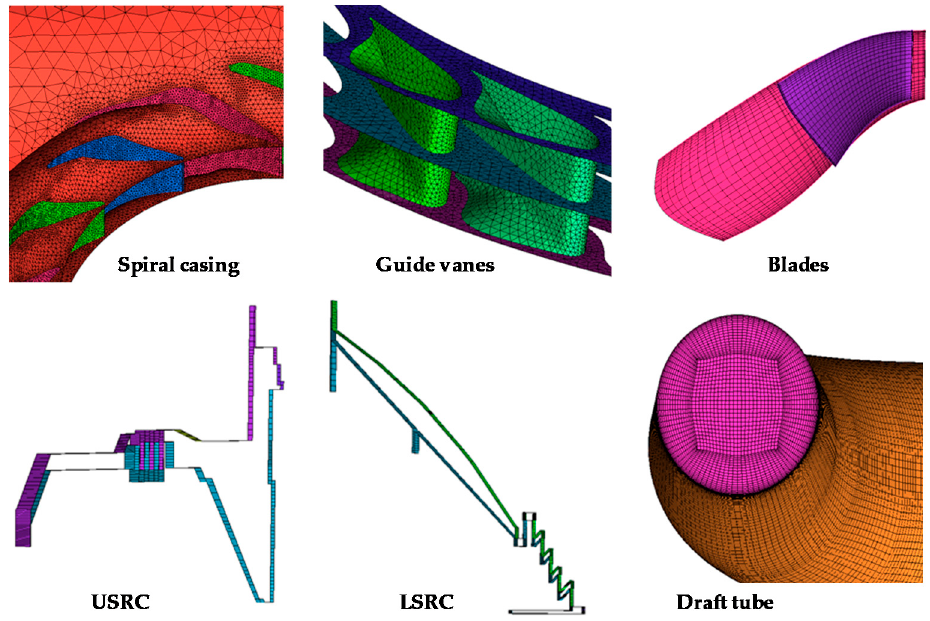
Figure 3. Meshing scheme of the multiscale passage computational domain.